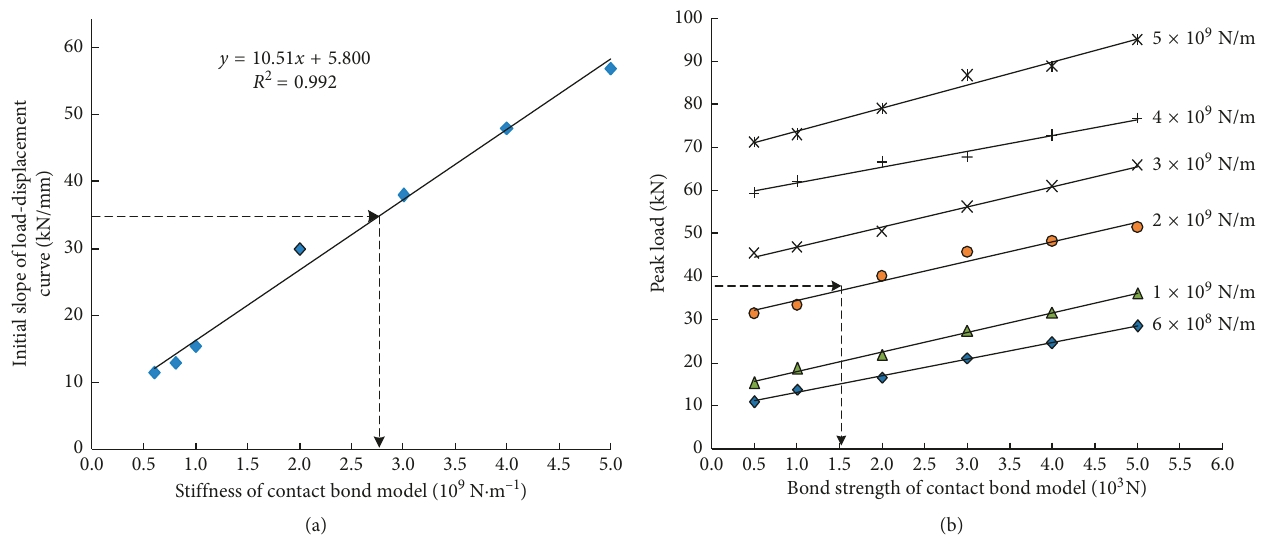
Figure 11: Parameters of the 2D contact bond model. (a) Original slope of the simulated splitting test curve versus stiffness. (b) Peak load of the simulated splitting test versus bond strength.